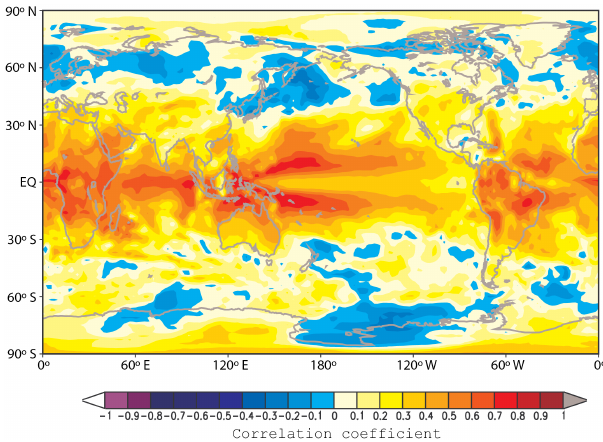
Figure 11. Correlation pattern between the global skin temperatures (temperatures of ocean and land surface) simulated in two past1000 simulations ( r 1 and r 2) (900–1849) with the Earth system model MPI-ESM in the June–August season after applying a 10-year low- pass